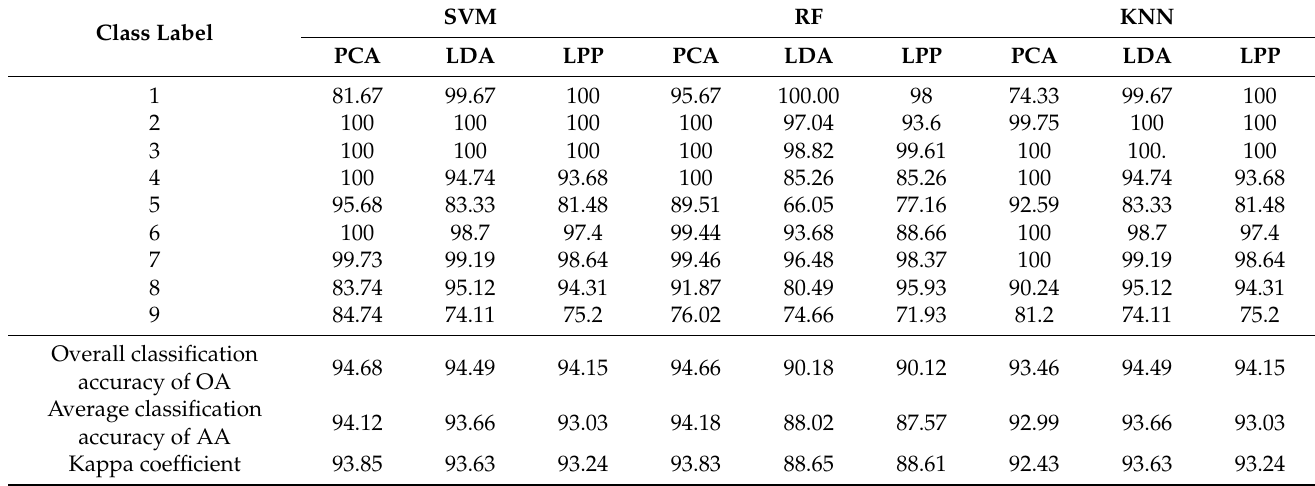
Table 2. Classification accuracy of Yellow River Estuary dataset